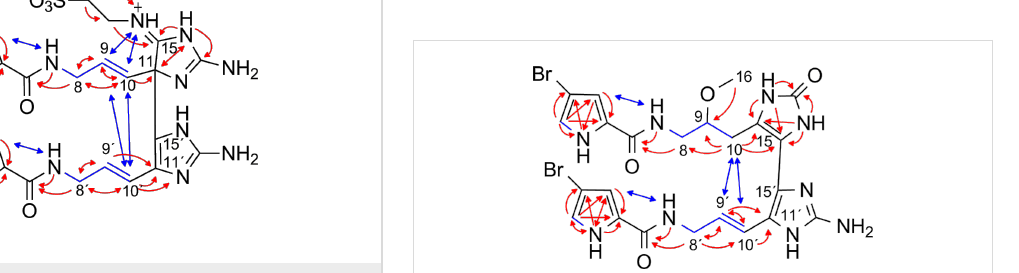
Figure 3: Selected 1 H, 1 H-COSY (blue bonds), 1 H, 1 H-NOESY (blue arrows), 1 H, 13 C-HMBC, and 1 H, 15 N-HMBC (both red arrows) correla- tions for citrinamine B ( 2 ).